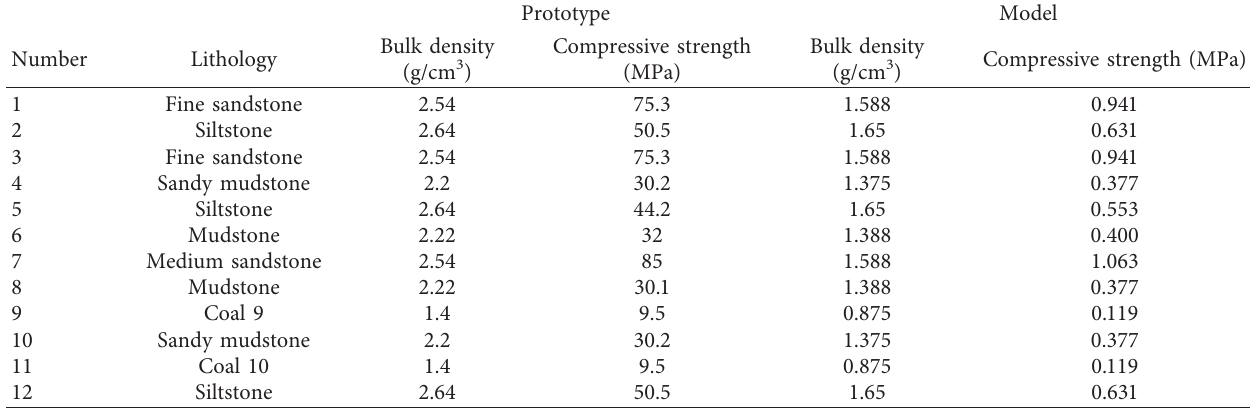
Table 2: Mechanics parameters of the similar rock material.